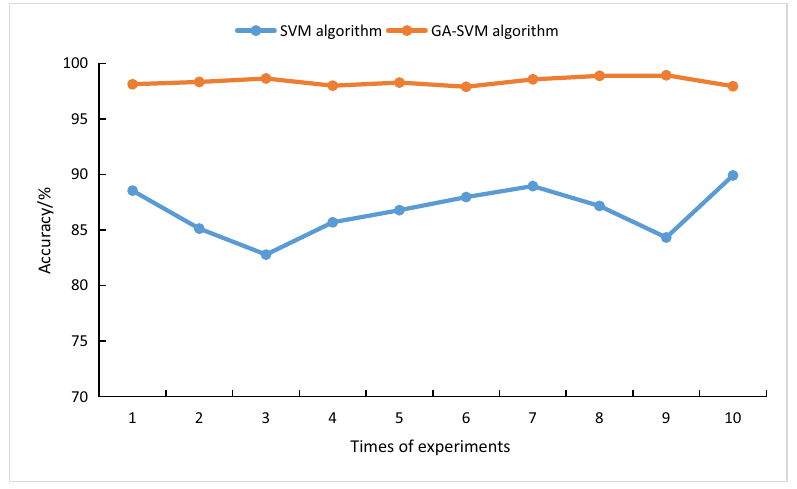
Figure 2: Comparison of the evaluation accuracy between the two